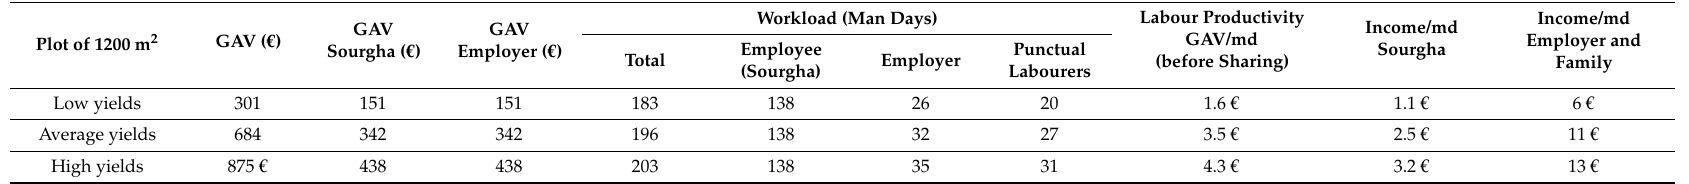
Table 6. Added value partition between employer and sourgha within an onion manual cultivation system using a mbeye seddo (benefit sharing contract).